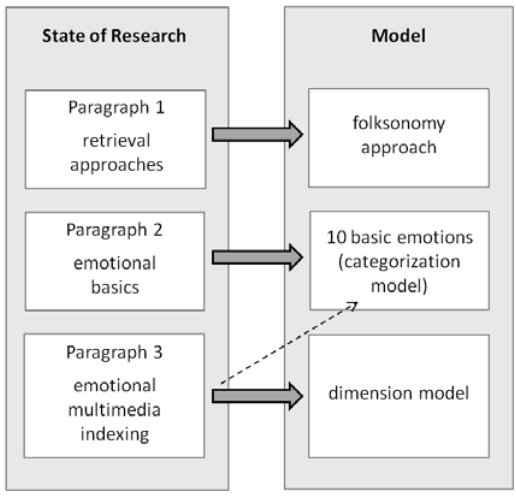
Figure 1. Our model used for